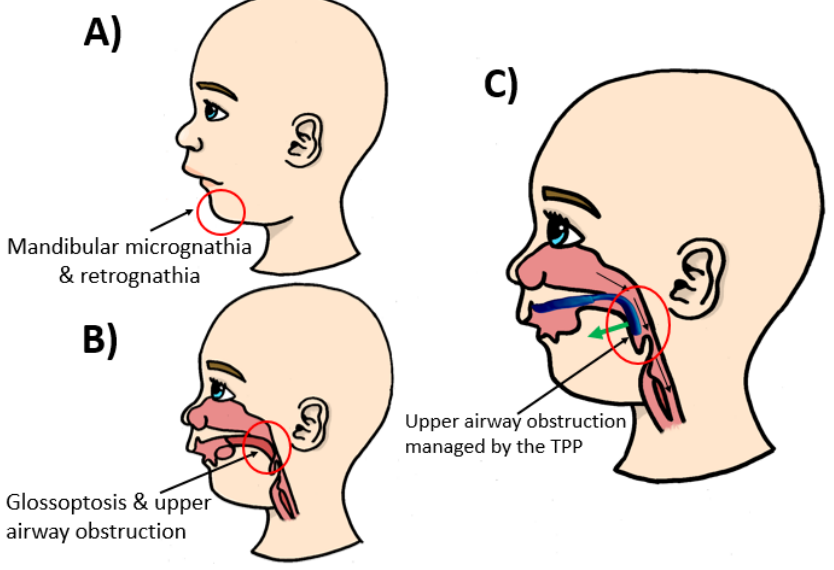
Figure 1. Anatomical condition and Tübingen palatal plate (TPP) positioning in patients with Robin sequence (RS). ( A , B ) Problems associated with the disease, such as mandibular retrognathia (receding jaw), micrognathia (small jaw) and glossoptosis (tongue placed further back than normal), which results in upper airway obstruction. ( C ) TPP solution for RS treatment and management of the airways by pulling the base of the tongue forward by a pre-epiglottic spur.